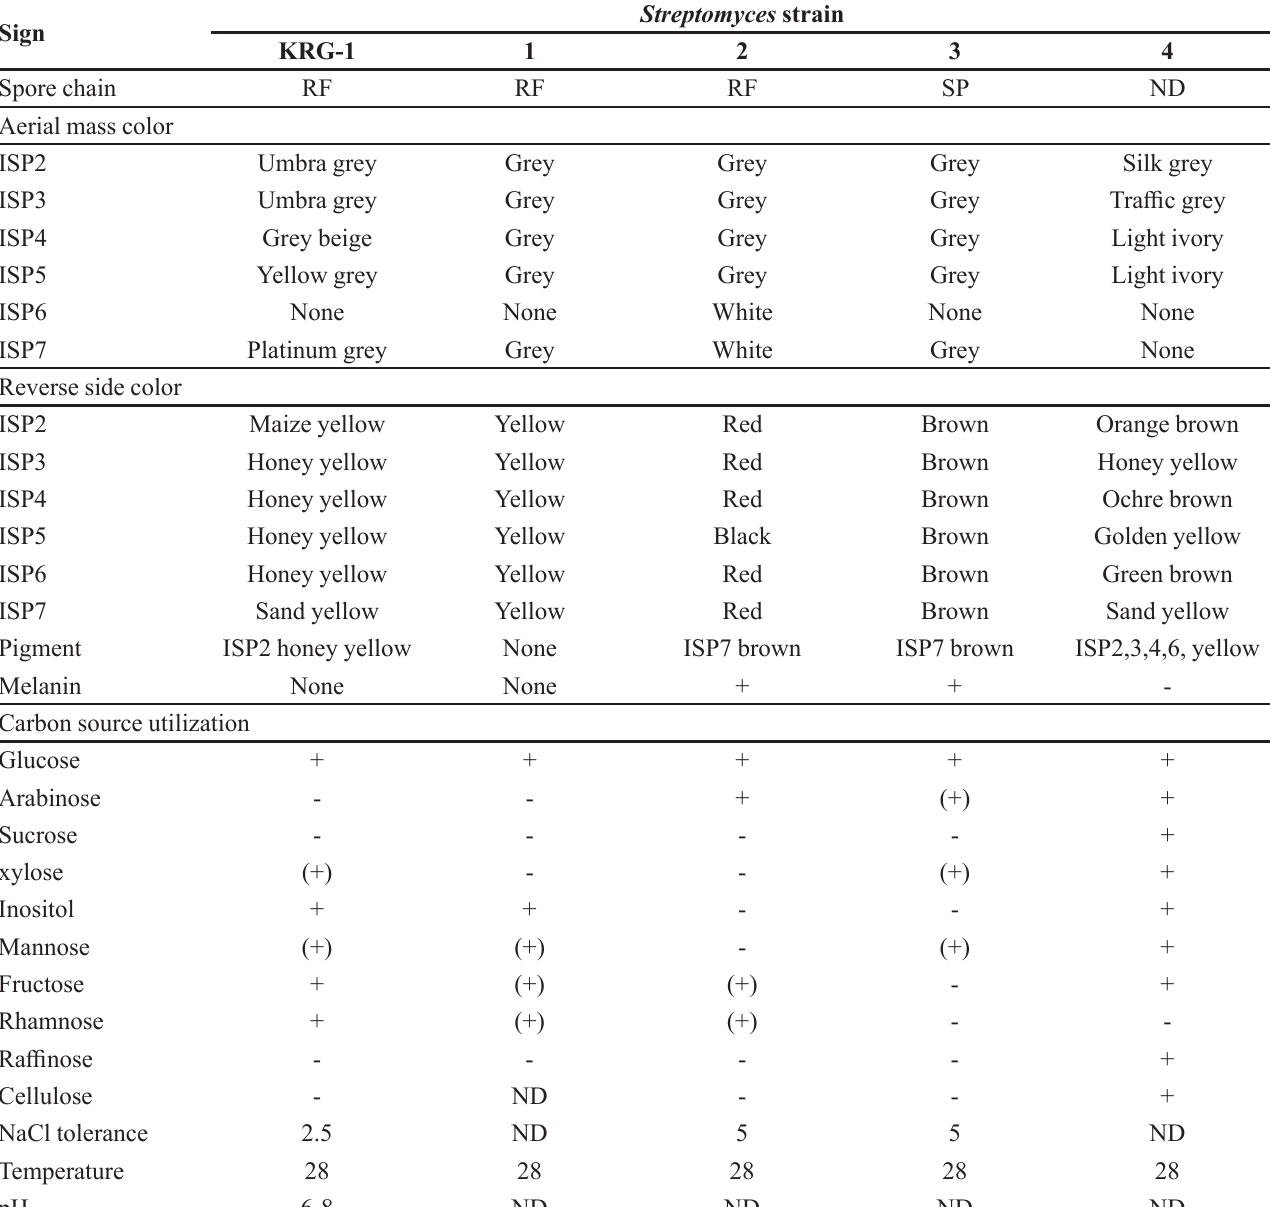
TABLE I - Morphological and physiological characteristic of strain KRG-1 and phylogenetically related Streptomyces species